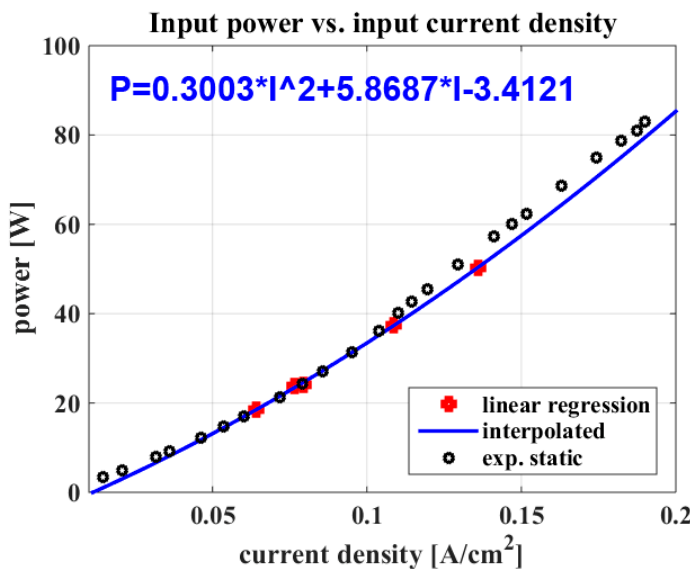
Figure 7. Static characteristic obtained by linear regression and experimental measurements.